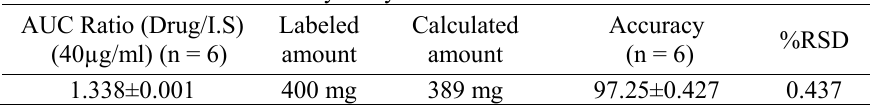
Table 2. Recovery study from formulation of